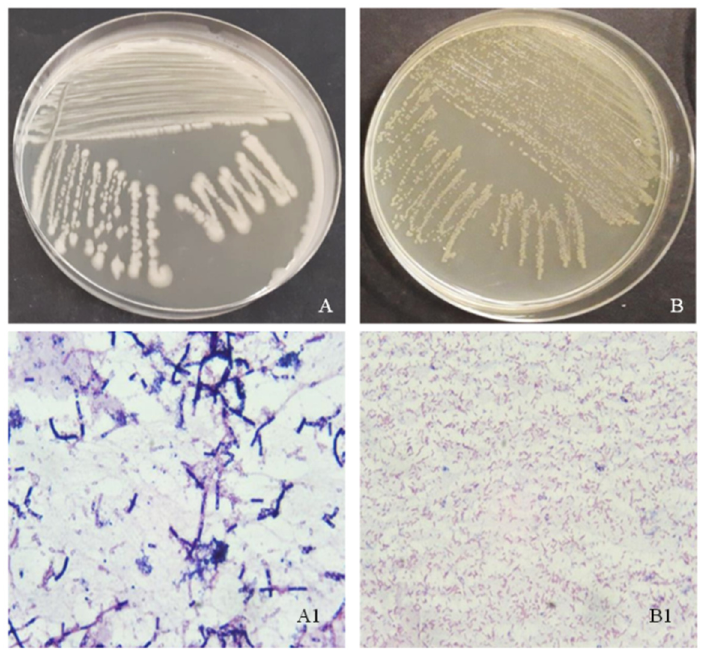
Figure 1. Bacteria ( A ) Bacillus cereus and ( B ) Pseudomonas alcaligenes cultivate on nutrient agar by streak plate method. Microphotos of bacterial Gram-stained smears, ( A1 ) Bacillus cereus, and ( B1 ) Pseudomonas alcaligenes at the microscope magnification of 1000×.